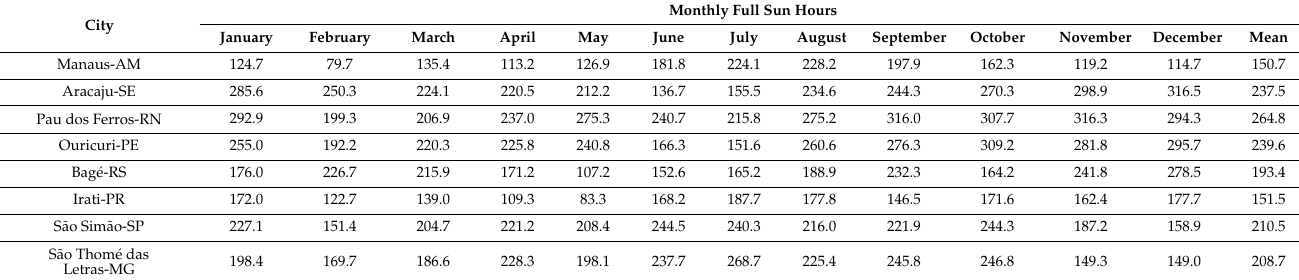
Table 3. Hours of average monthly insolation in the analyzed